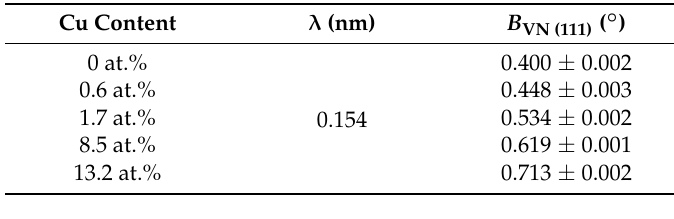
Table 3. The values of λ and B obtained from XRD patterns.